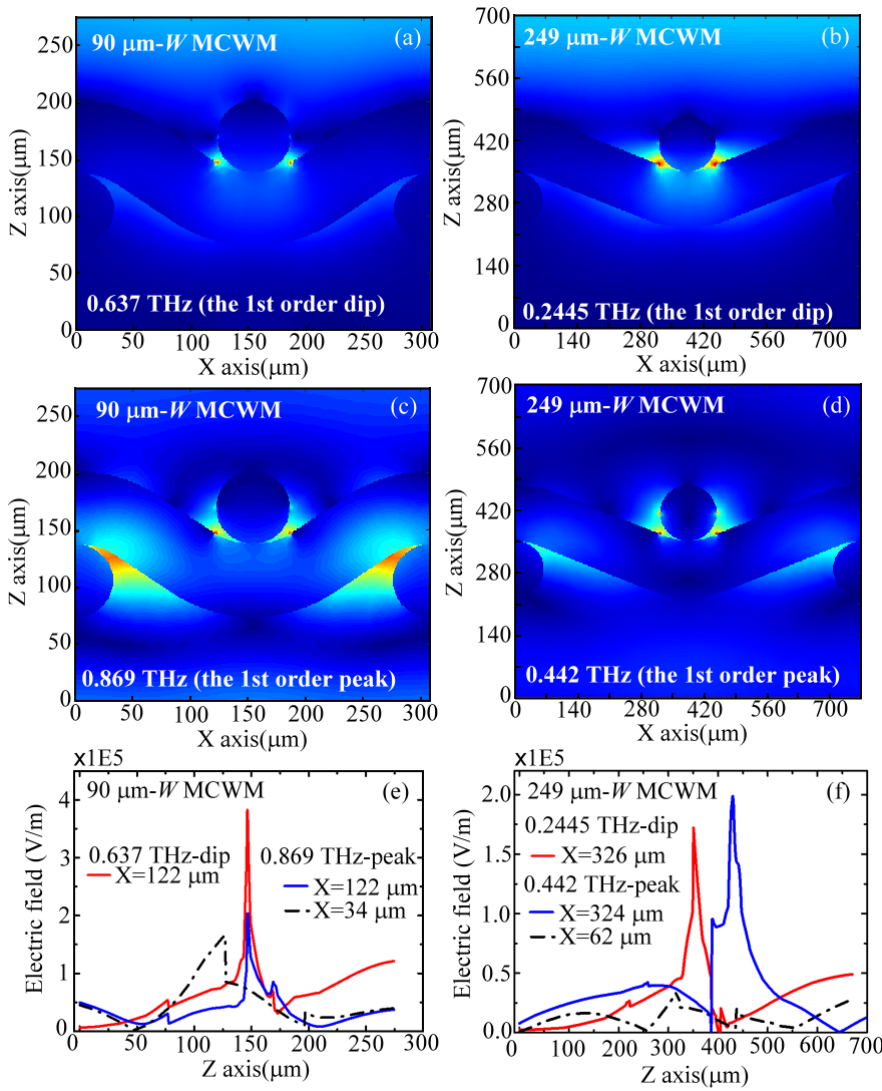
Figure 3. Simulated ( a – d ) X–Z lateral modal profiles and ( e , f ) Z -axial electric field distributions of 90 and 249 μ m W MCWMs at the first-order spectral dips and peaks.